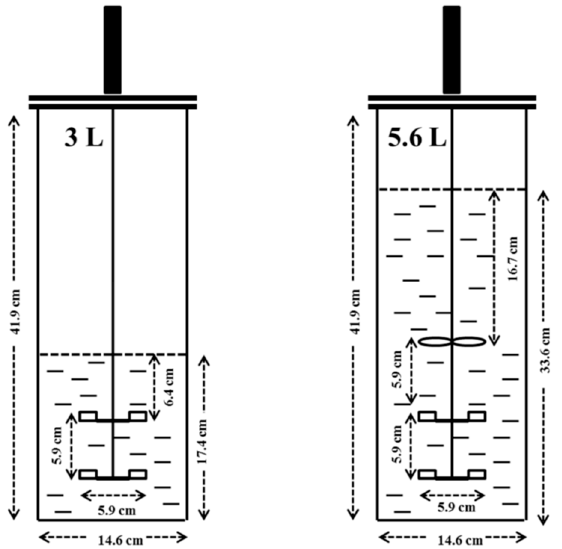
Figure 1. 7-L Bioflo 415 continuous stirred-tank reactor (CSTR) with the 3 and 5.6 L working volumes and impellers configuration.